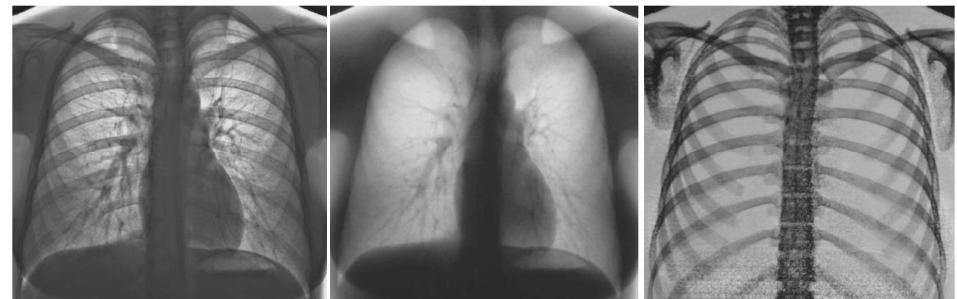
Figure 6. Images obtained on a prototype dual energy digital chest radiographic unit at the University of Alabama Birmingham circa 1985 with a single exposure: the conventional digital image was obtained by adding the low and high energy images ( left ); soft tissue image ( center ) and bone image ( right ) [124,125].